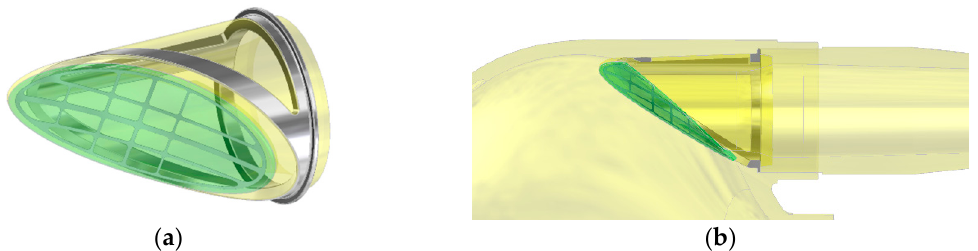
Figure 1. Inflow valve ( a ) and cross section, ( b ) through the flow channel area.